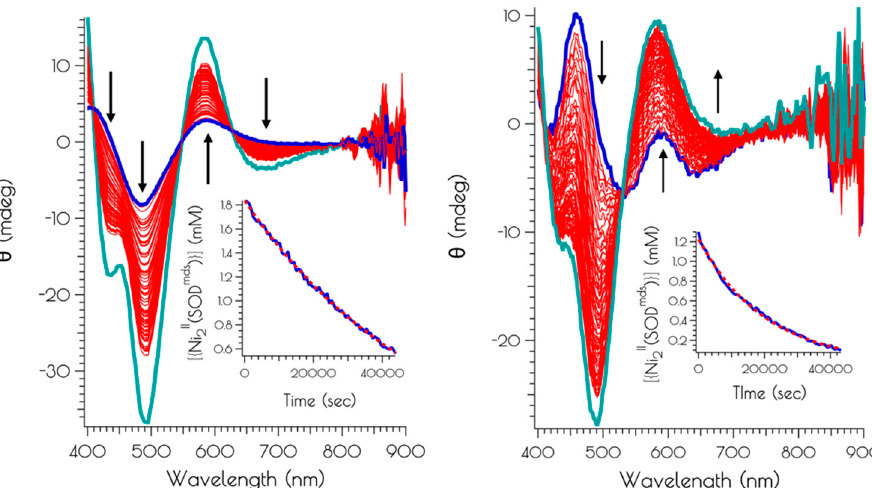
Figure 8. CD spectra following the air oxidation of {Ni 2II (SOD mds )} at pH 7.4 (left) and 9.6 (right), with the blue spectra representing the trace at t = 0 s, the red spectra representing the traces recorded every 600 s (10 min) over the course of 12 h, and the teal spectra represent the CD spectra of the solutions following 24 h of O 2 exposure. The insets depict the kinetics traces highlighting the decay of {Ni 2II (SOD mds )} (blue trace) and best fit of the kinetic trace to a first order rate law.